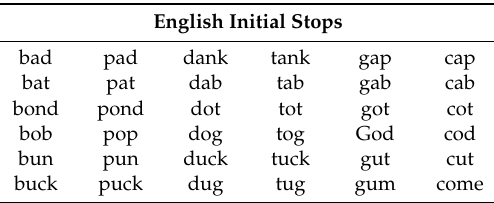
Table A1. English minimal pairs with voiced and voiceless plosives in word-initial position.